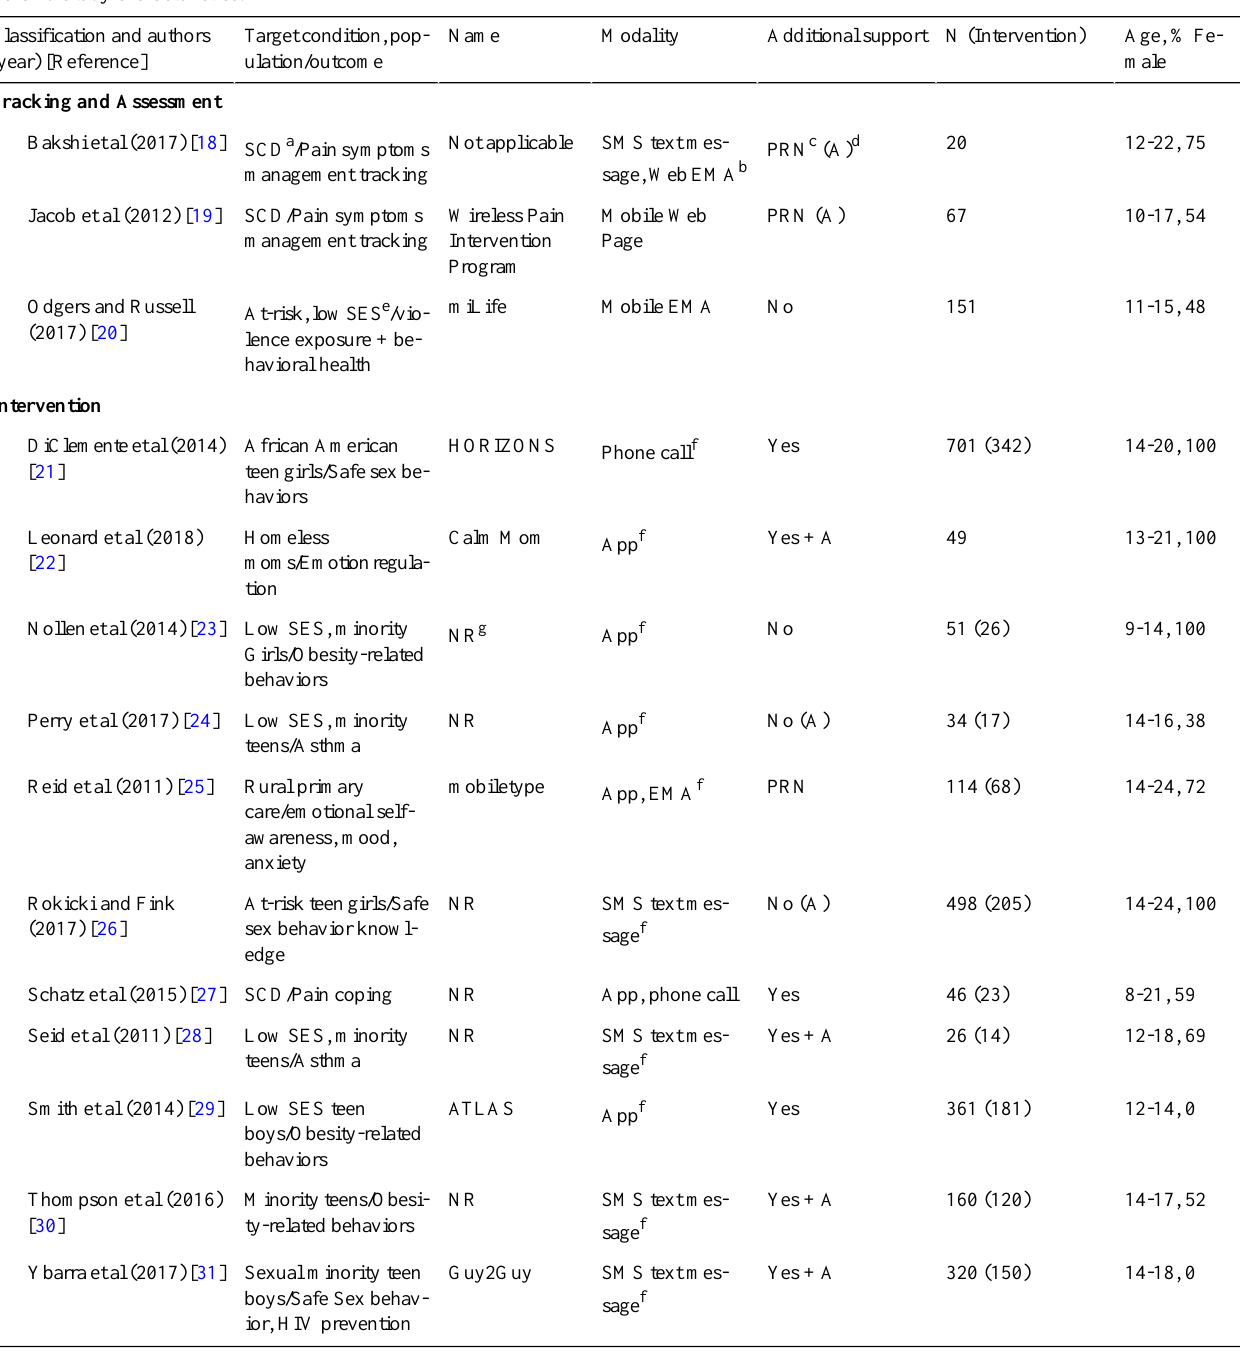
Table 1. Study characteristics.